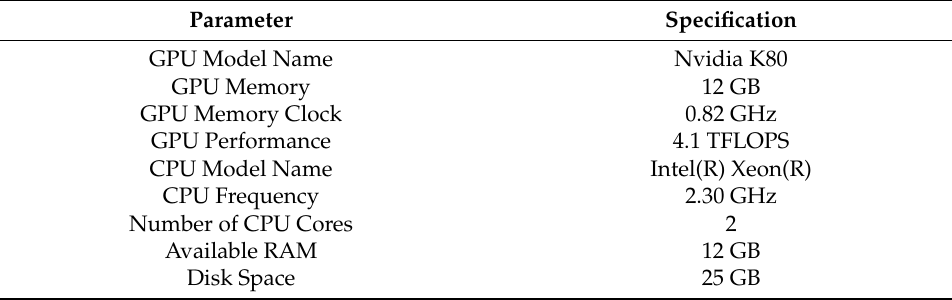
Table 4. Hardware specifications of Google